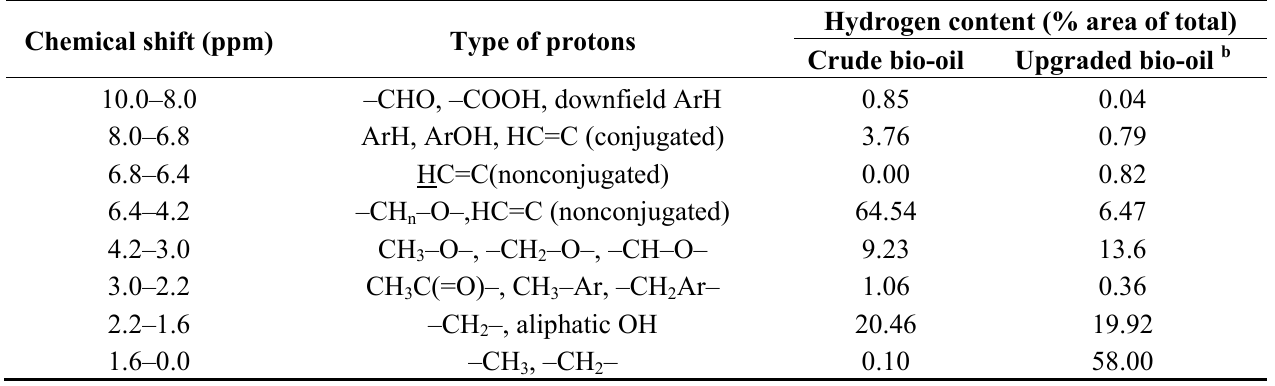
Table 4. Nuclear magnetic resonance ( 1 H-NMR) chemical shift assignments and relative abundances for crude bio-oil and upgraded bio-oil a .